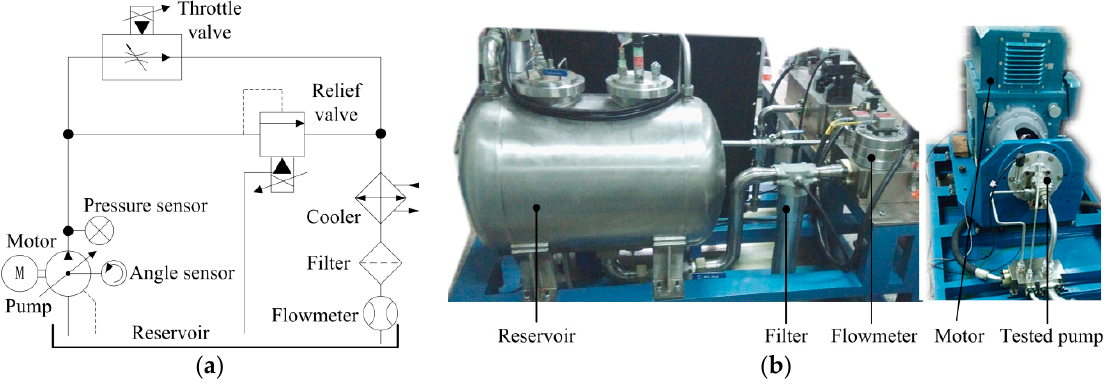
Figure 3. The test rig. ( a ) Schematic sketch of the test rig and ( b ) structure of the test rig.